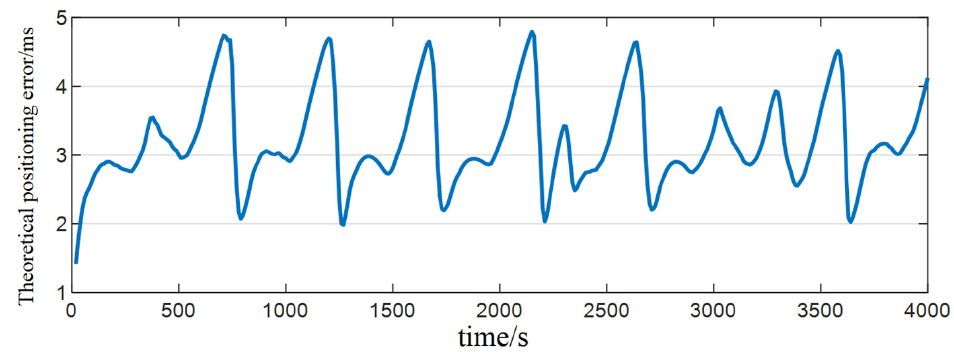
Figure 15. Theoretical relative distance between the master and slave AUVs.